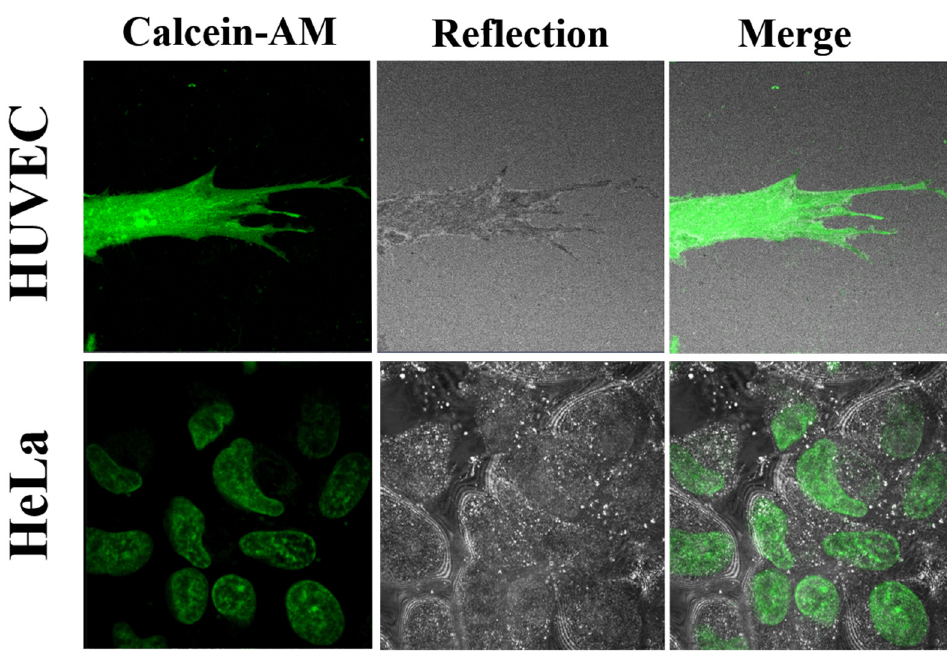
Figure 5. Representative CLSM images of HUVEC cells and HeLa cells stained by Calcein-AM using a standard protocol (Calcein-AM (2 µ M) in fluorescent and reflected mode and merged. Confocal laser scanning microscopes (CLSM) with a water immersion objective Zeiss 40 × /NA 1.2 were ap- plied.